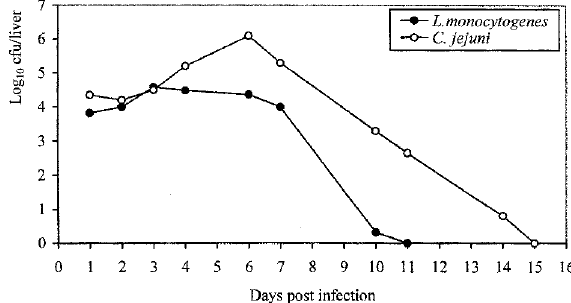
FIG. 1. Growth curve of L. monocytogenes and C. jejuni in the liver of C57BL/6 mice infected intraperitoneally with 0.5–1 ´ 10 6 viable Listeria and 0.5–1 ´ 10 9 Campylobacter . Each point represents the median value of bacteria recovered from groups of five mice. Data are expressed as log 10 cfu per